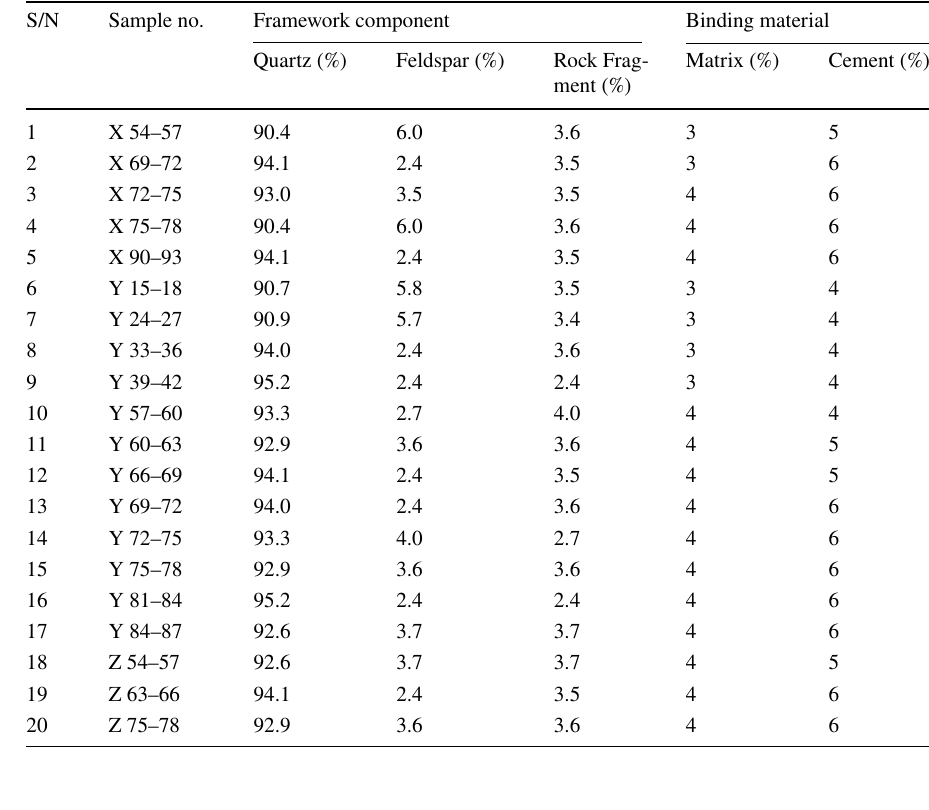
Table 4 Frequencies of the framework elements and binding